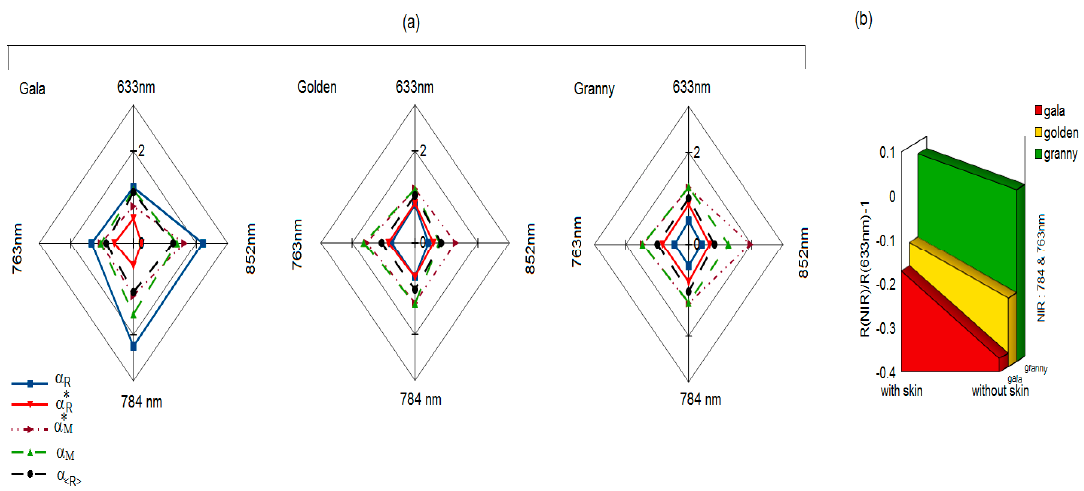
Figure 9. ( a ) Web diagrams related to the five ratios ( α R , α * R , α M , α * M , α <R> ) for the three apple cultivars Royal Gala, Golden Delicious and Granny Smith tested at four wavelengths 633, 763, 784, and 852 nm; ( b ) Pigment index ( CI ) estimated with and without skin.